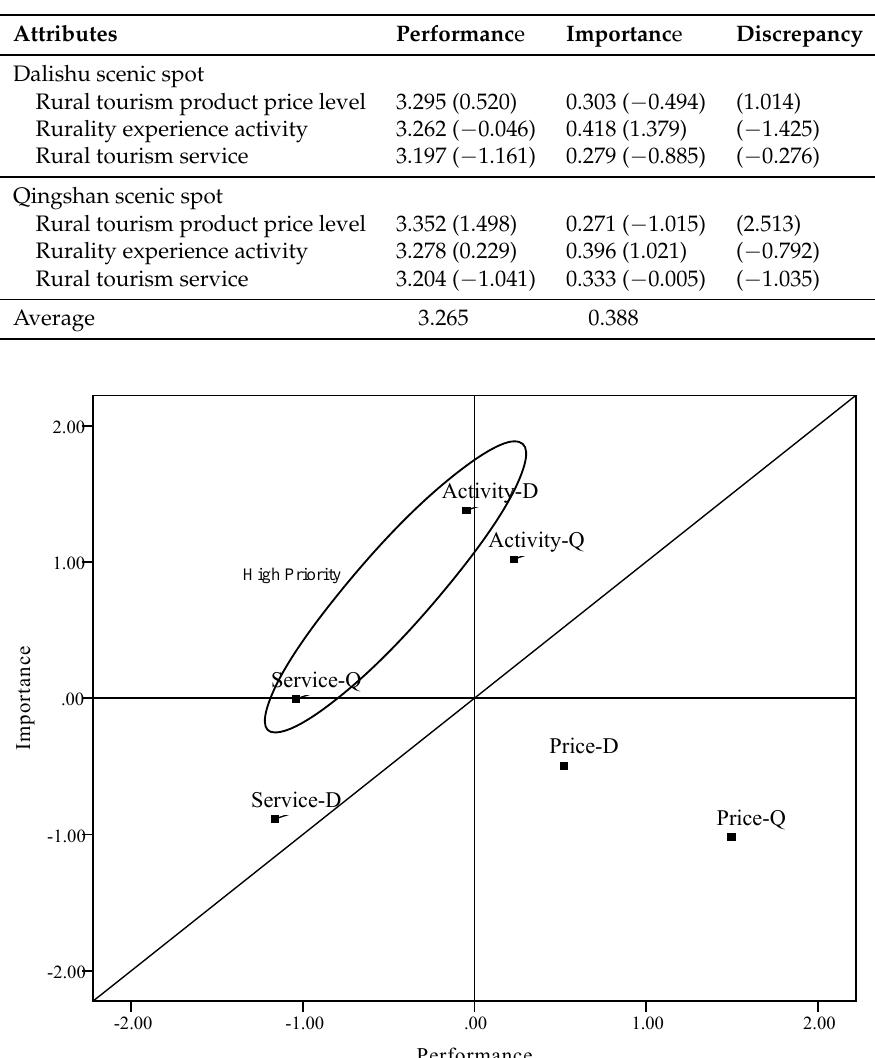
Figure 6. Importance-performance grid for attributes (D: Dalishu scenic spots; Q: Qingshan scenic